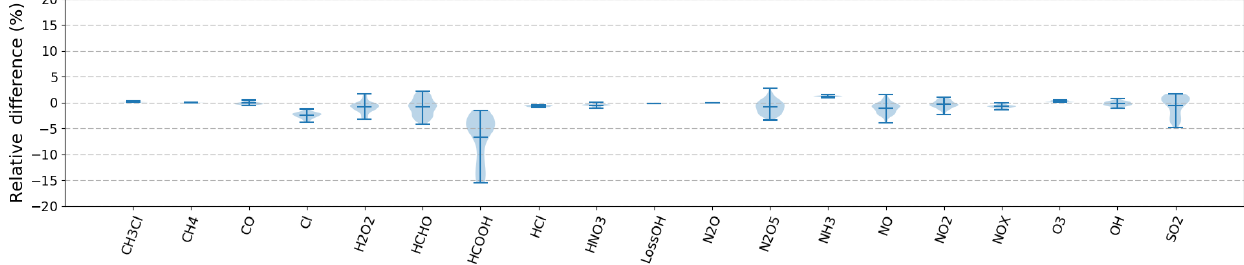
Figure 3. Aggregated mass difference between the accelerated and non-accelerated versions in the final month after 2 years of simulation time for different chemical species with the SCAV (scavenging) submodel disabled.